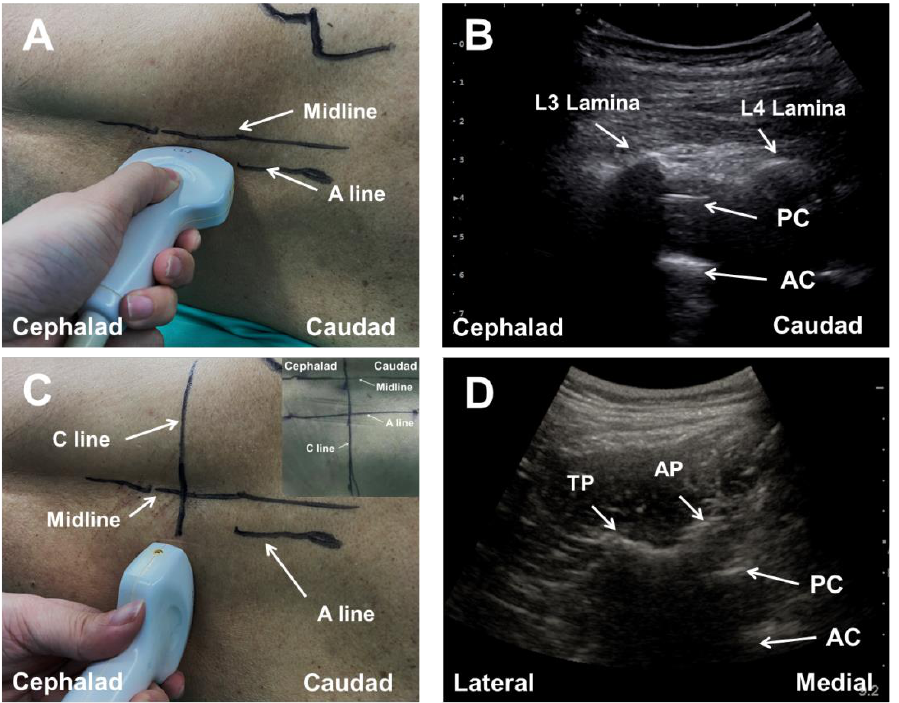
Figure 3. Dual-plane ultrasonic scan-assisted positioning. The probe was first placed at the lum- bosacral region to perform the paramedian sagittal oblique scan (Panel ( A )). The scanning line (A line) was marked on the patient’s skin when the target intervertebral space was imaged on the midline of the sonogram (Panel ( B )). Then, the probe was rotated 90 degrees counterclockwise to perform the paramedian transverse oblique scan with the ultrasound beam directed medially (Panel ( C )). The scanning line (C line) was then marked on the patient’s back when the target intervertebral space was visualized on the sonogram (Panel ( D )). The intersection point of A line and C line was the target puncture site for spinal anesthesia, which was illustrated in the upper right corner of the ( C ). AC, anterior complex; PC, posterior complex; TP, transverse process.